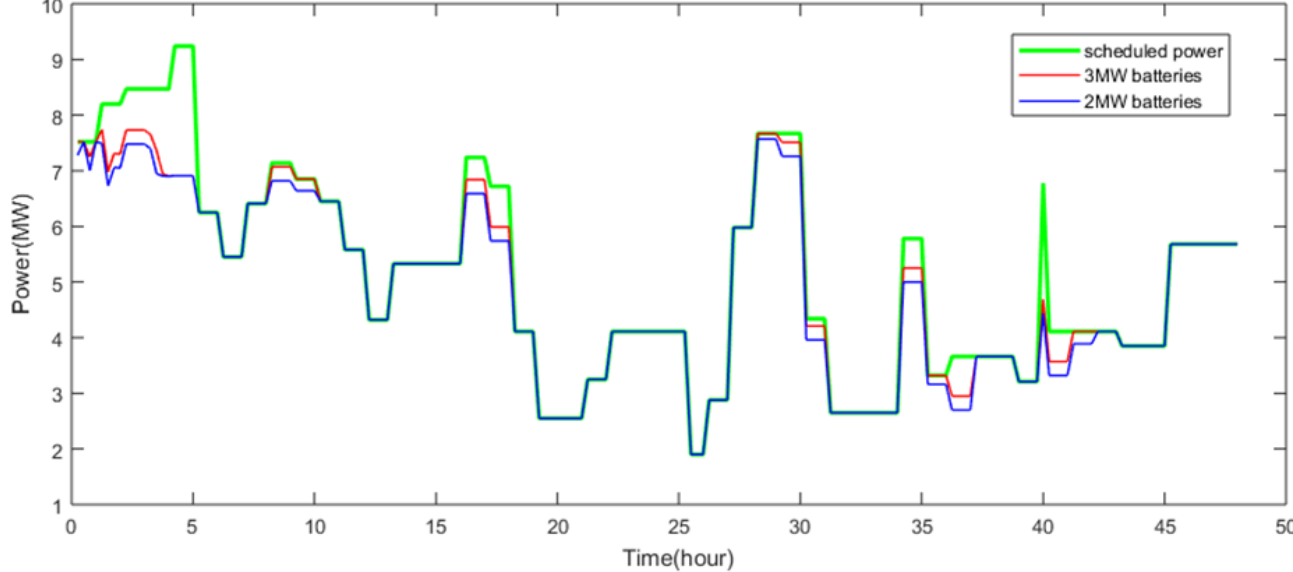
Figure 13. Power curve of output of BESS-integrated wind farm under 2 and 3 MW of battery in simultaneous state exchanging strategy. Table 8. Input parameters of two 2 MW batteries and the two 3 MW batteries.